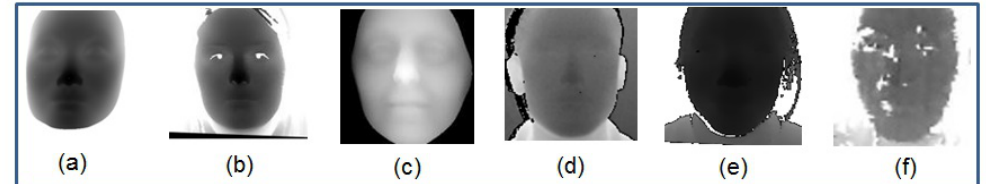
Figure 1. Depth images captured by different devices or under different conditions show different quality levels. From left to right: ( a ) Facial depth images captured by SCU 3D scanner [17] (in our collected database), ( b ) Konica Minolta Vivid 910 [18] and ( c ) 3dMD [19] in lab, ( d ) Kinect II in lab